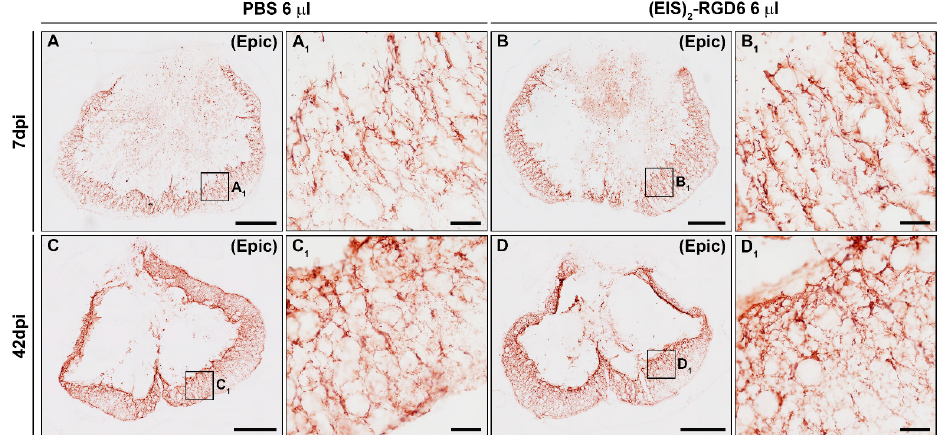
Figure 19. Representative images from glial fibrillary acidic protein (GFAP) immunostained sections. Representative images of GFAP immunostained spinal cord sections corresponding to the lesion epicentre, used to carry out the densitometrical analysis of astroglial reactivity in experiment (EIS) 2 -RGD6 III at 7 and 42 days post-injury (dpi): ( A , A 1 ) PBS 6 µ L group at 7 dpi; ( B , B 1 ) (EIS) 2 -RGD6 6 µ L group at 7 dpi; ( C , C 1 ) PBS 6 µ L group at 42 dpi; and ( D , D 1 ) (EIS) 2 -RGD6 6 µ L group at 42 dpi. Scale bars in ( A – D ), 500 µ m. Scale bars in ( A 1 – D 1 ), 50 µ m. Please note that data obtained from the densitometric analysis of astroglial reactivity in these sections can be found in Figure 16E,F.